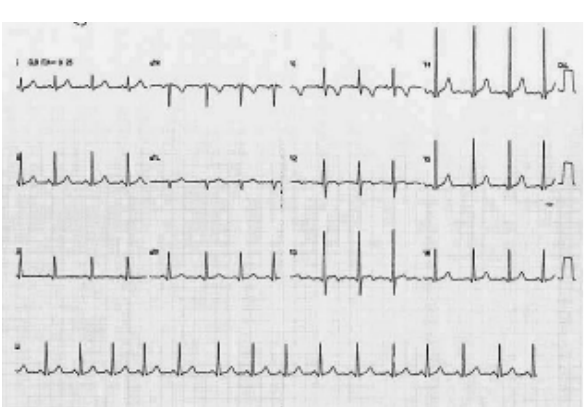
Fig. 1 – Eletrocardiograma pré-operatório sem sinais diretos de hipertrofia ventricular esquerda